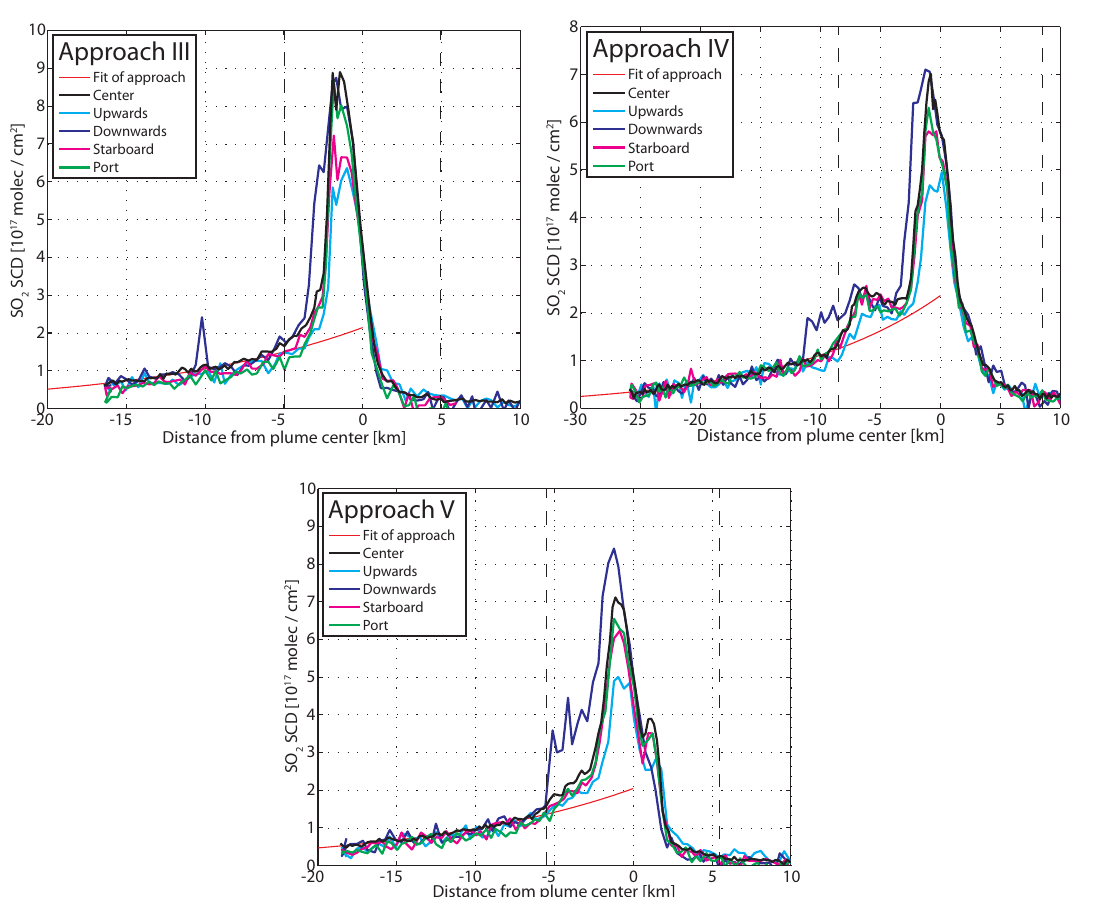
Fig. 6. Results from approaches III–V. The solid red lines indicate the fit of Eq. (2) to the measurement results in the far field. Dashed vertical lines indicate regime C. Errors of measurements are given in Table 1. SO 2 was detected from the first measurements onwards. Significant differences between the retrieved SCDs of the telescopes can not be distinguished for measurements at greater distance to the plume due the inferior signal-to-noise ratio of the Ocean Optics S2000 spectrometers (up, down, starboard, port viewing directions). Still, a vertical extension of the volcanic plume of at least 2km can be deduced from the measurements at different vertical